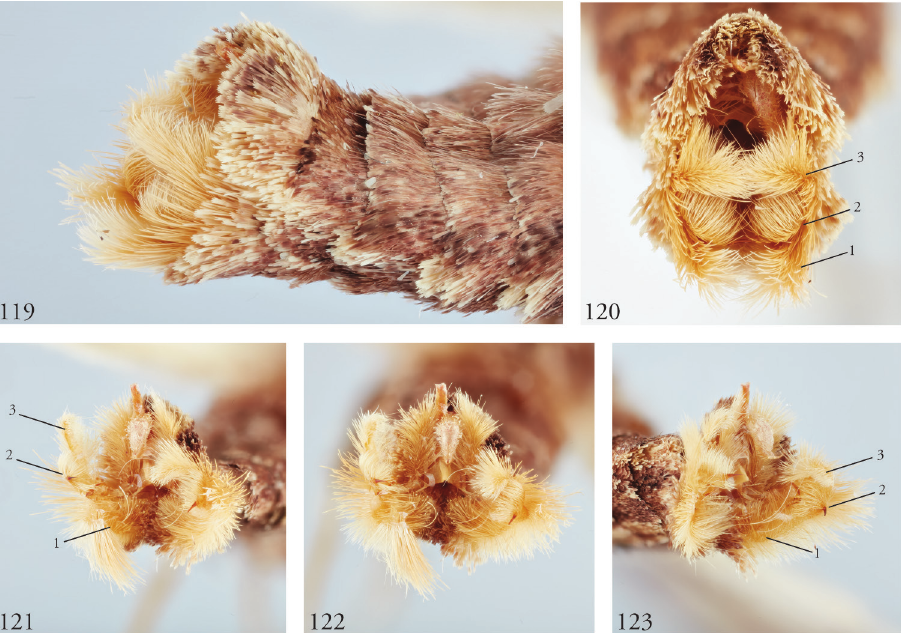
Figures 119–123. Leucosigma chloe male terminalia illustrating orientation of tufts in situ , with struc- tures labeled as in previous figures to indicate (1) sacculus; (2) cucullus and (3) dorsal process. 119–120 L. chloe , Área de Conservación Guanacaste (ACG), Costa Rica,96-SRNP-11373, USNMENT01437360 119 Lateral 120 Caudal 121–123 L. chloe , ACG, 96-SRNP-11371, USNMENT01370286.